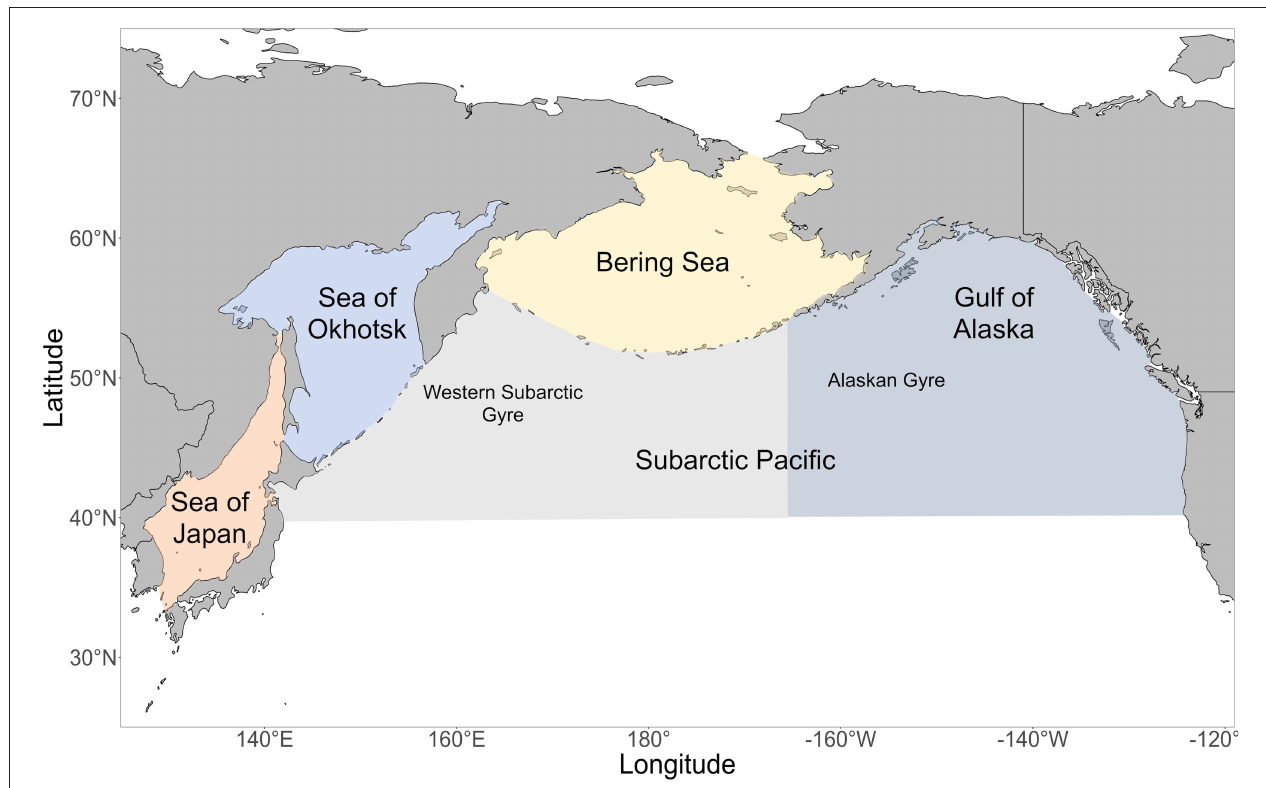
FIGURE 1 | A map of the regions in the North Pacific Ocean. In the Subarctic Pacific, the area east of 165 ◦ E is the Gulf of Alaska / Eastern Subarctic and the area west of 165 ◦ E is the Western Subarctic.